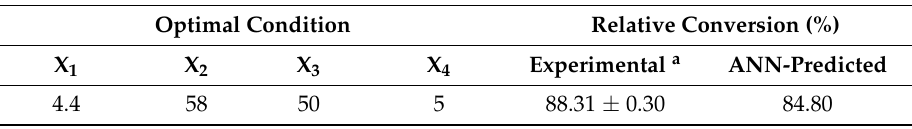
Table 3. An optimal trial obtained from the ANN